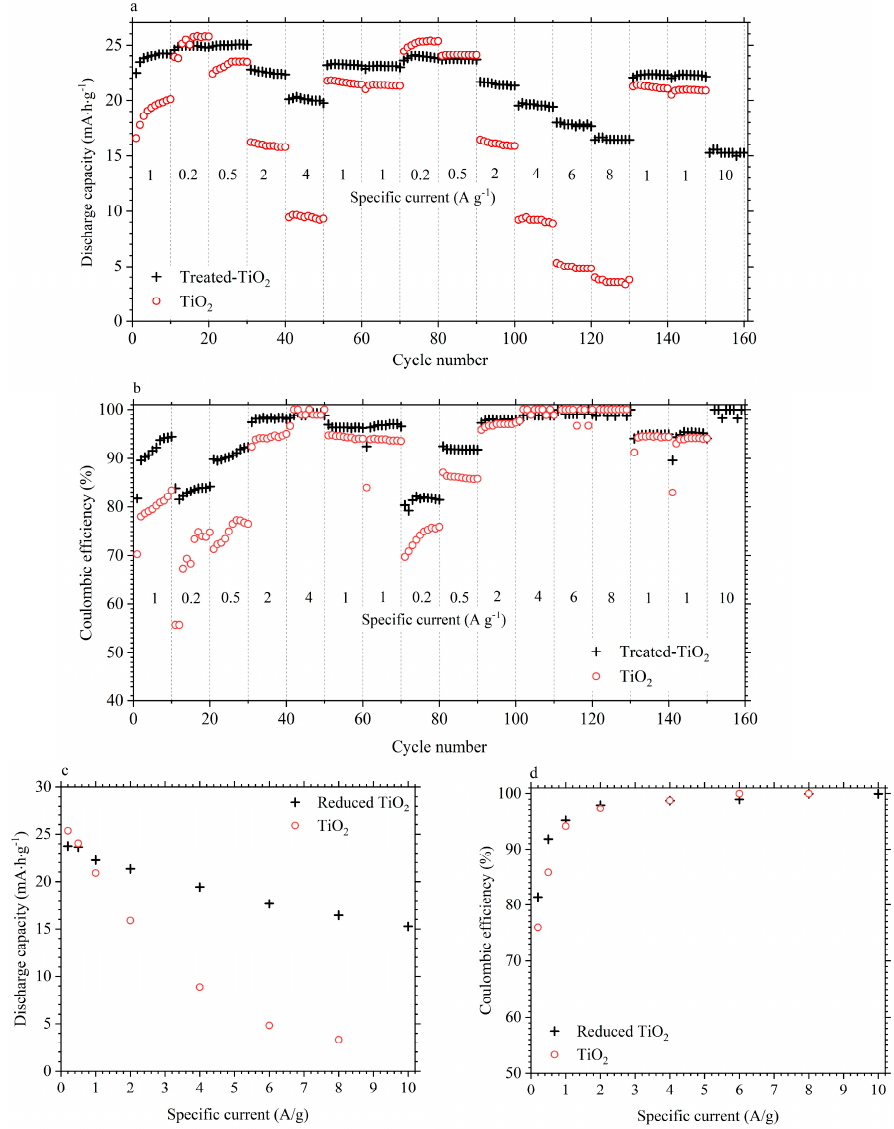
Figure 5. Discharge capacity ( a ) and coulombic efficiency ( b ) of a treated-TiO 2 (black cross) and TiO 2 electrode (red circle), at various specific currents, plotted against cycle number; ( c ) Compares the discharge capacity and ( d ) the coulombic efficiency at each specific current. Electrodes were cycled in